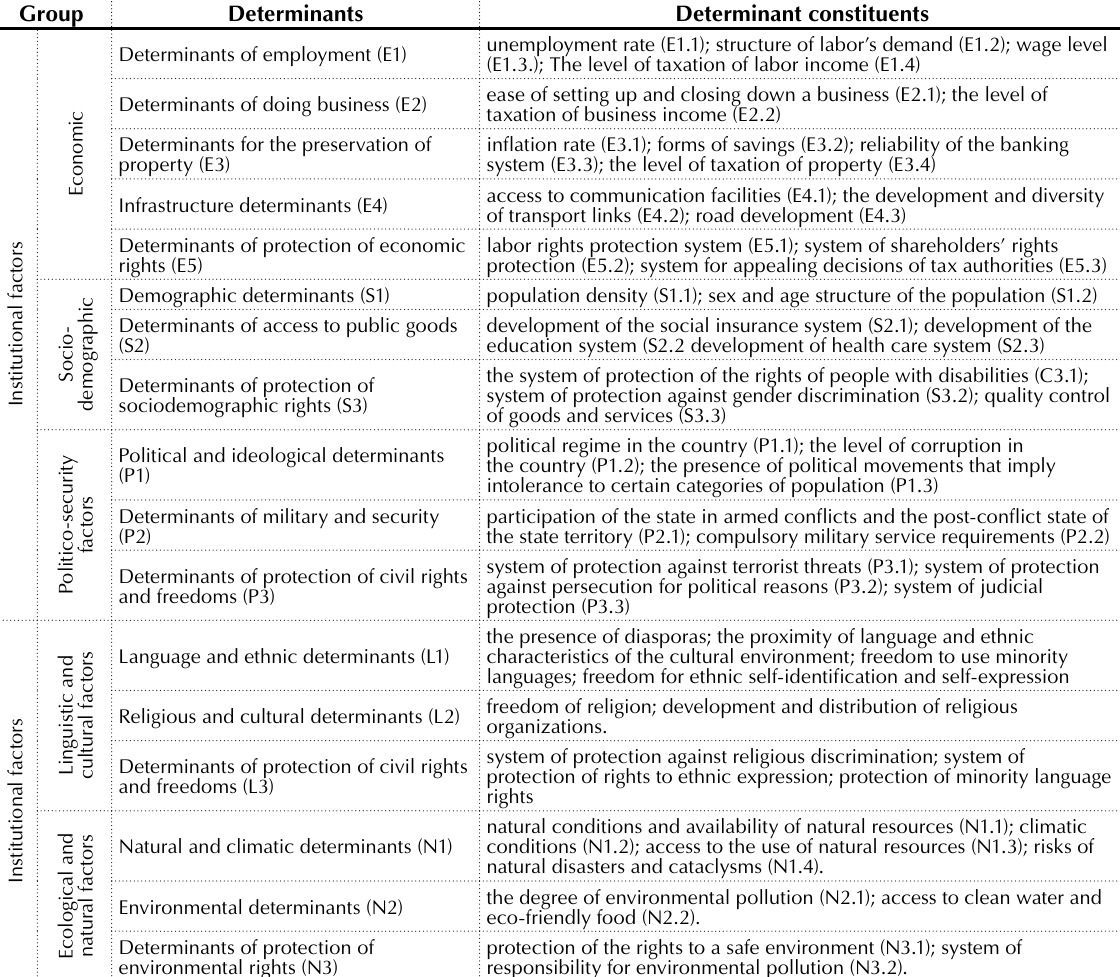
Table 3. Determinants of migration motives